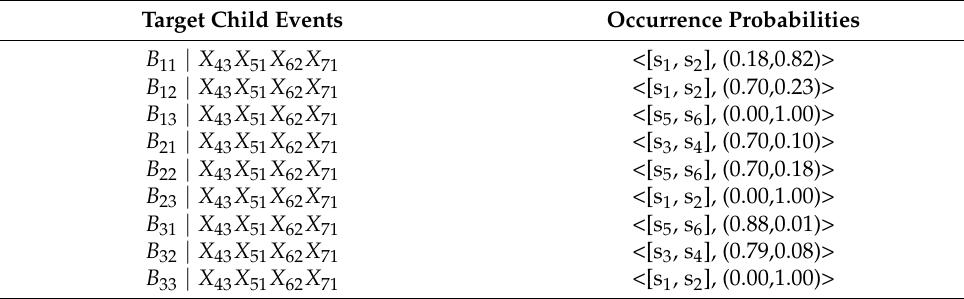
Table 4. The occurrence probabilities of target child events. Target Child